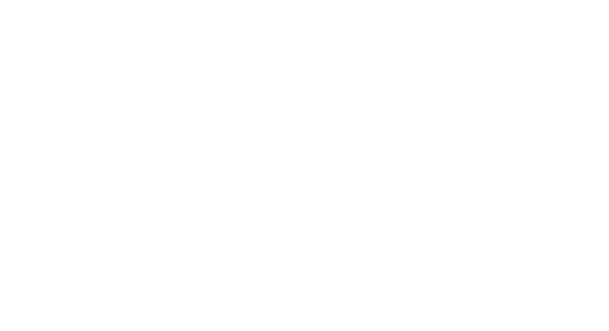
Figure 2. The circuitry for the direct measurement, according to [9], of the common-mode attenuation and reflection of the four-port presented in Figure